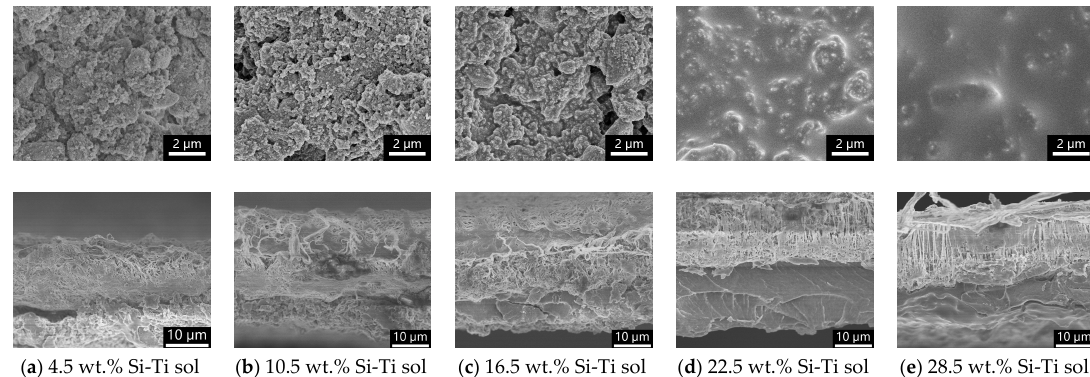
Figure 4 . High-power and cross-section SEM images of MSQ aerogel coating on ePTFE thin films with different Si-Ti sol contents. ( a ) 4.5 wt.%, ( b ) 10.5 wt.%, ( c ) 16.5 wt.%, ( d ) 22.5 wt.%, ( e ) 28.5 wt.%